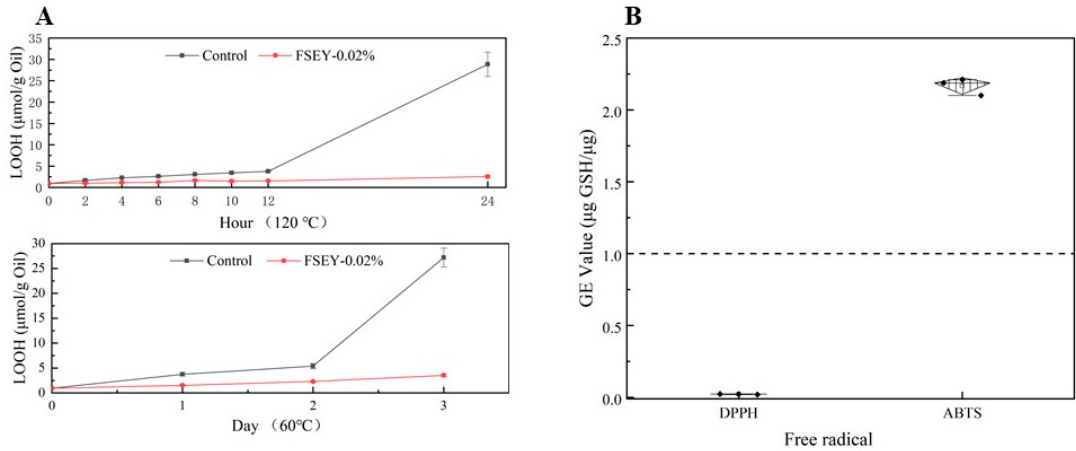
Figure 8. ( A ) Changes in primary lipid oxidation product values stored at 60 and 120 °C. ( B ) Capacities of FSEY in terms of scavenging DPPH and ABTS radicals. Values are expressed as mean ± SD ( n = 3) .